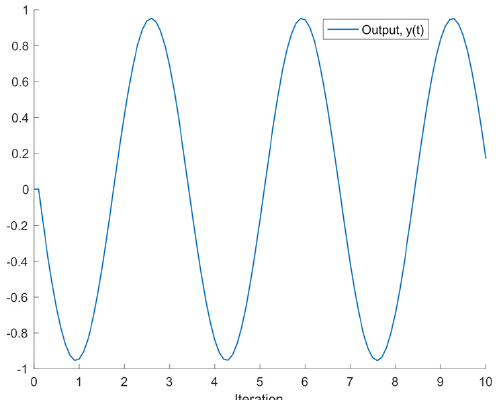
Figure 14. Output of the stable singular system ( E 0 , A 0 ) in Example 7.